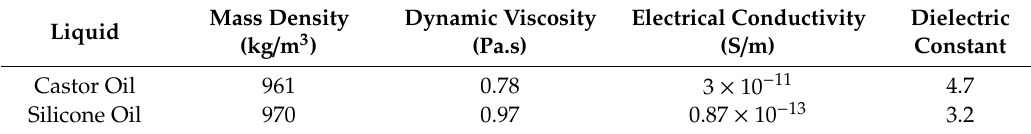
Figure 1. Experimental setup used for measuring the droplet distortion under an applied electric field. Charged coupled device (CCD) camera was used. Table 1. Physical properties of the tested base liquids [5].